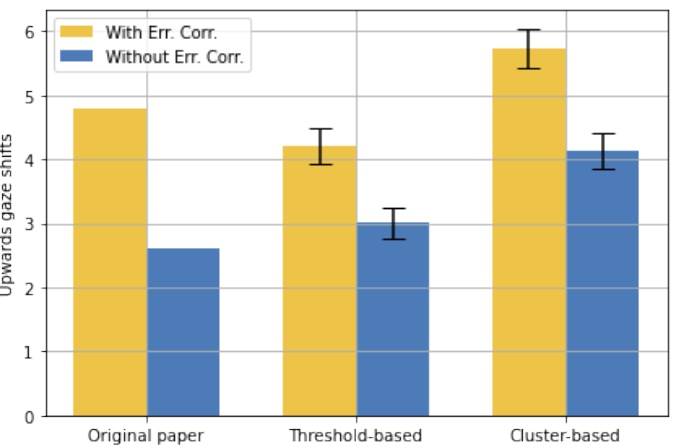
Figure 11. Number of gaze shifts from the keyboard to the text area in Jiang et al.’s paper, and with our two detection